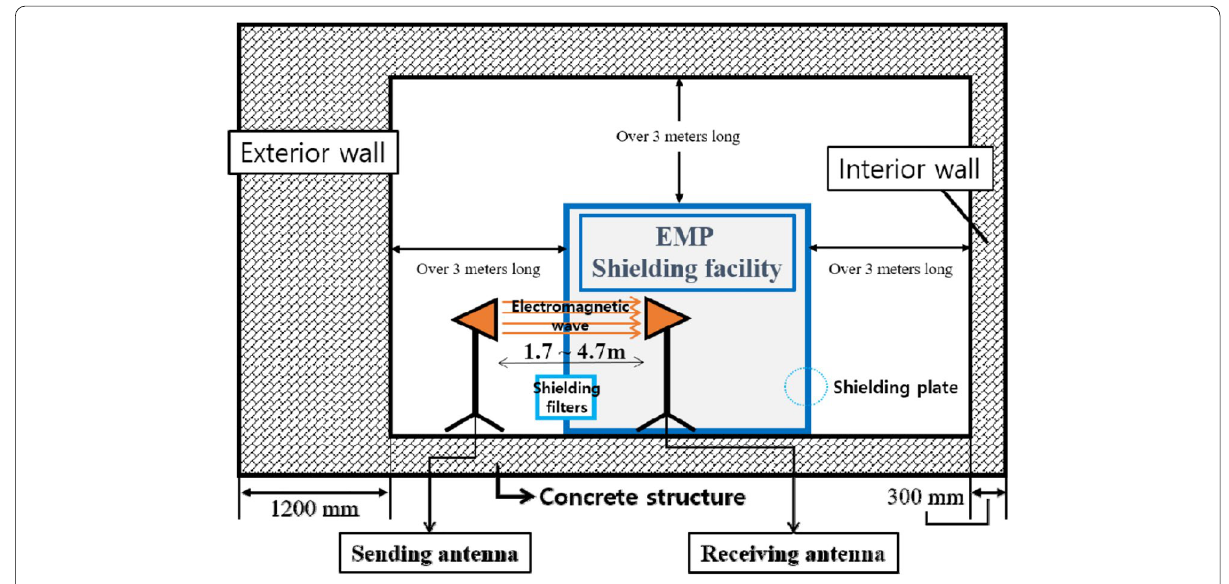
Fig. 1 Concept of a typical EMP shielding room.